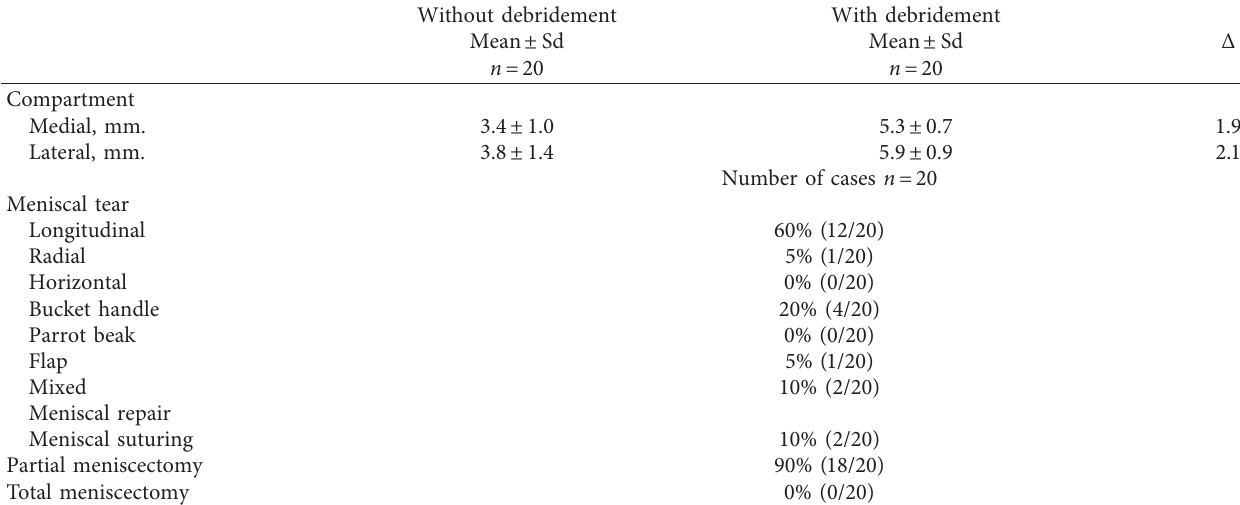
Table 1: Descriptive statistics of joint space width, meniscal tear, and